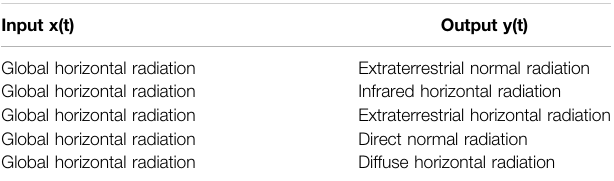
TABLE 2 | Inputs and outputs used in the linear modeling.